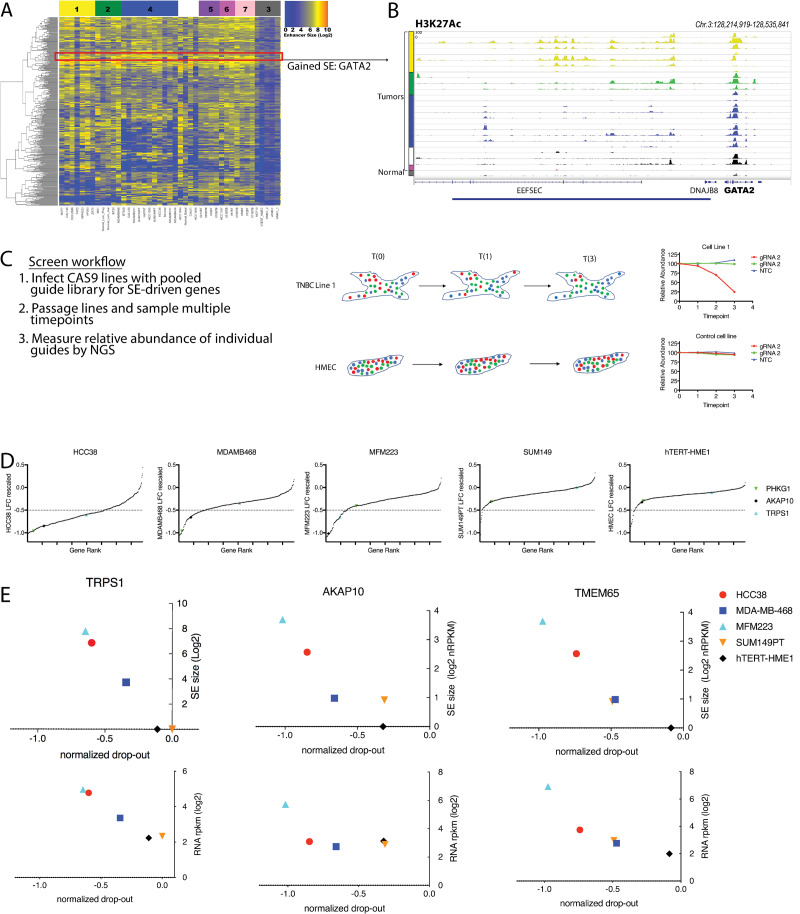
Tumor specific super-enhancers drive oncogene expression.A) Heatmap of tumor specific SEs across all samples as defined by scoring as a SE in at least 4 tumor cell lines and 1 TNBC primary tumor, and by not a SE in all normal samples. B) Example ChIP-Seq tracks for an acquired SE, putatively driving expression of GATA2. C) Diagram of screen workflow. D) CRISPR drop out screen results for tumor-specific SE associated genes in the indicated cell lines. E) Representative example screen hits. Top panel plots compare gene drop-out to SE size, bottom panel plots compare drop-out to RNA expression.